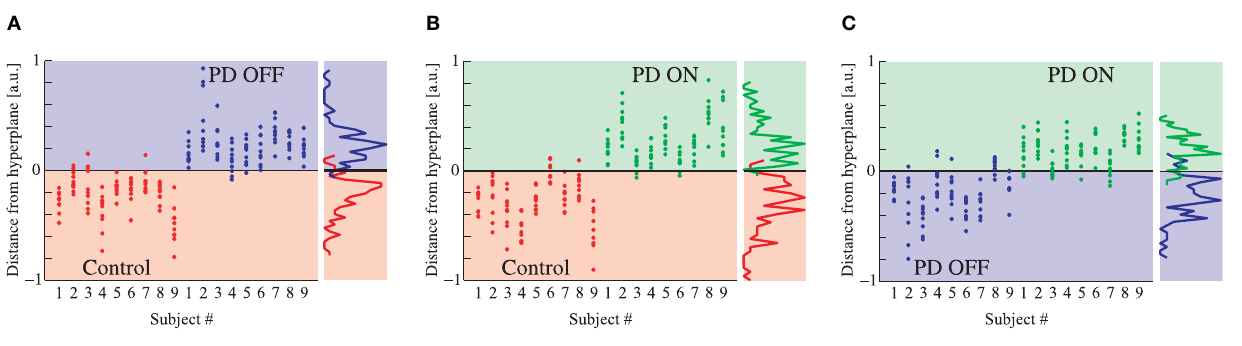
FIGURE 3 | (A) DDE model output distance from the hyperplane in classification of controls vs. PD patients off medications, (B) controls vs. PD patients on medications, and (C) PD patients on vs. off medications. Each column represents all 10 cluster classification outputs for a given